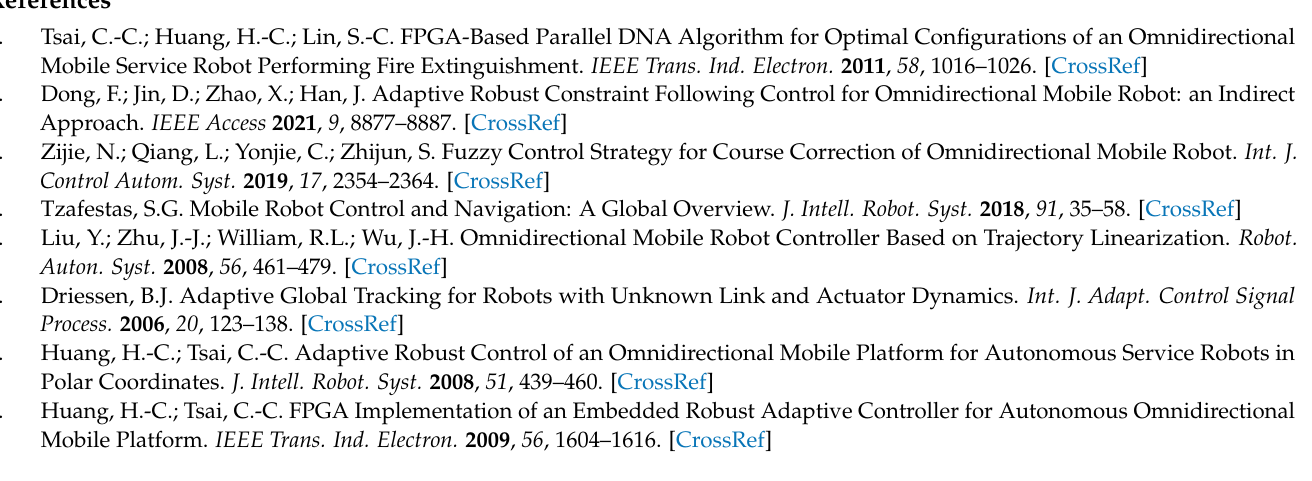
Figure 8. Control effort in Case 2